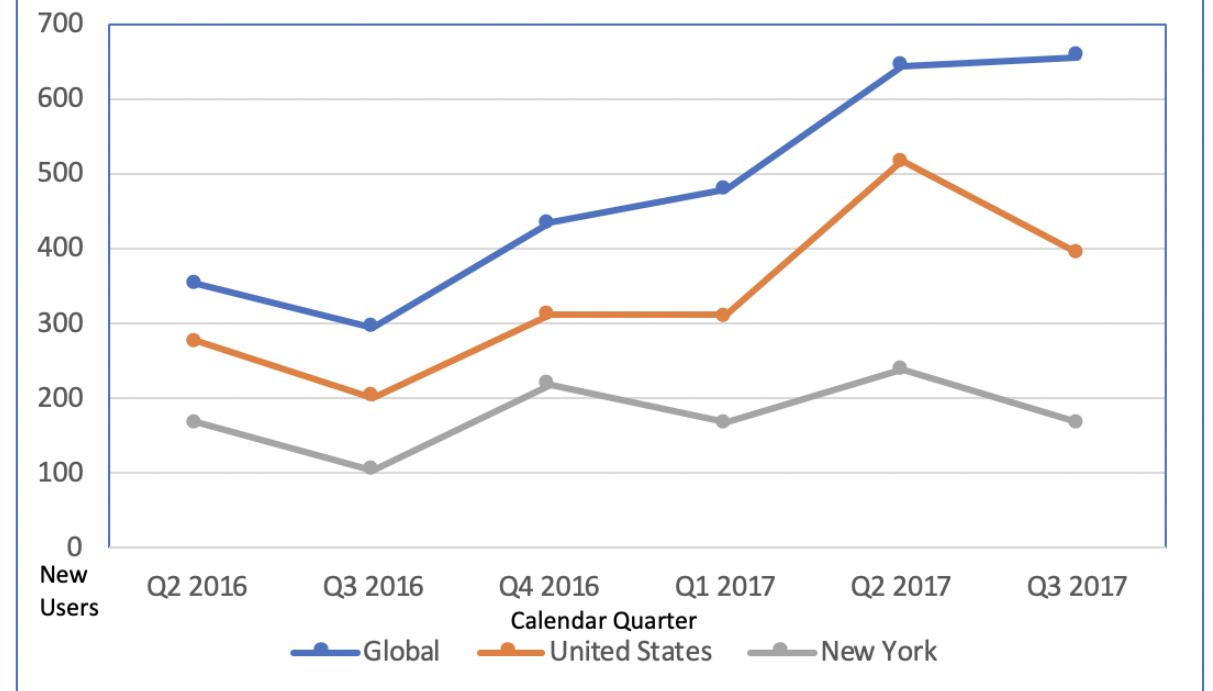
Figure 1. New users of the Management of Anticoagulation in the Periprocedural Period App by calendar quarter (Q) as defined by Google